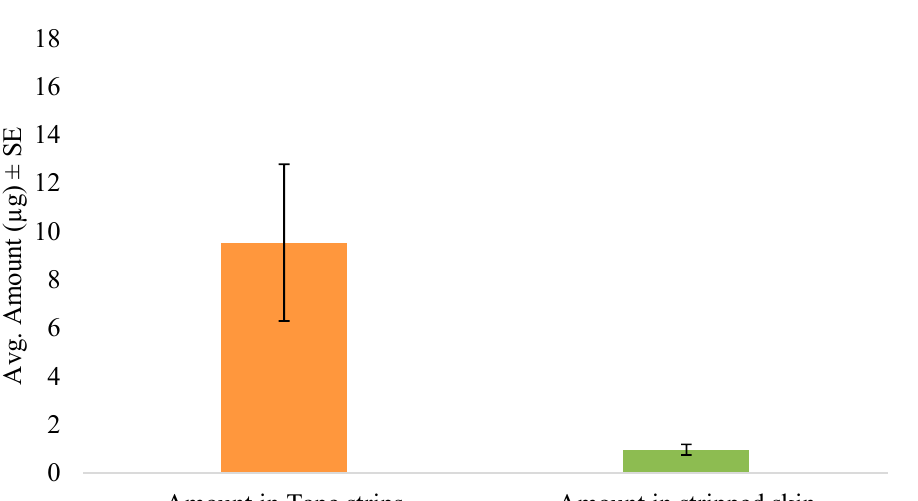
Figure 3. Amount of SN in tape strips and stripped skin following unsteady-state conditions (5 min).